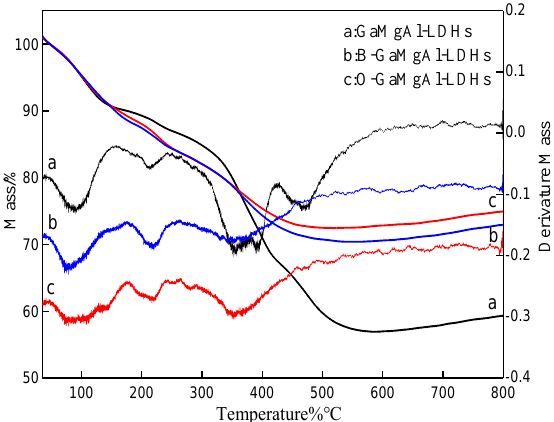
Figure 4. TGA/DTG curves of CaMgAl-LDHs, B-CaMgAl-LDHs and O-CaMgAl-LDHs